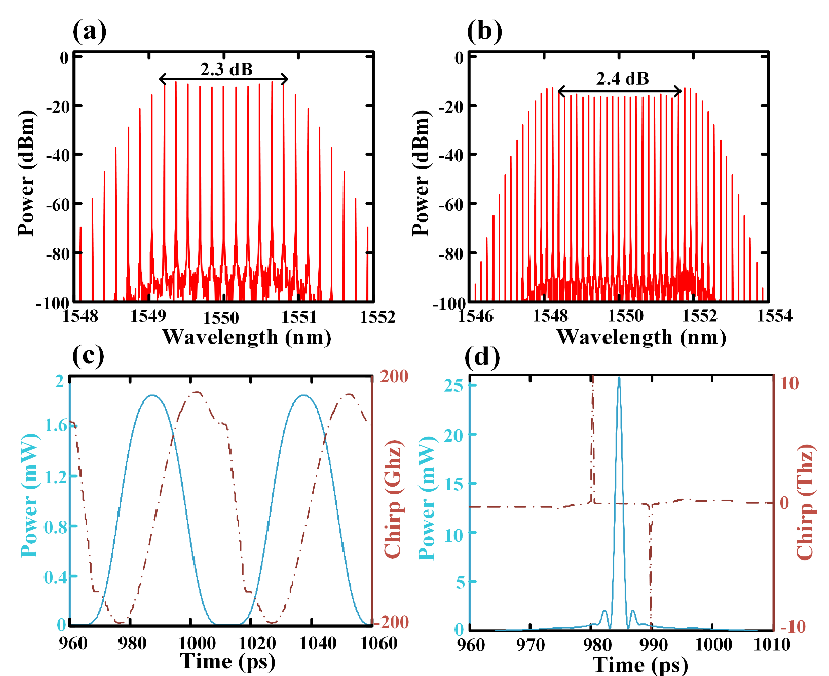
Figure 2. ( a ) The spectrum of OFC generated by a single MZM; ( b ) the spectrum of OFC generated by cascaded dual-drive MZM and phase modulator; ( c ) the time domain of the pulse after phase modulator; ( d ) the time domain and chirp of the pulse after the compression of single-mode fiber.